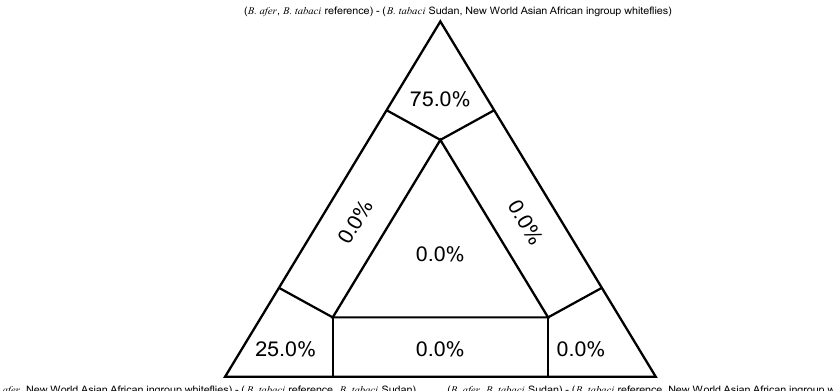
Figure 3. Likelihood map produced from IQ-tree showing the distribution of quartets that support a sister relationship between the reference “B” genome and the Sudan sample produced from the analysis of the concatenated alignment. Results show that 75% of quartets sampled support the Sudan sample together with the remaining samples (not including the reference) while 25% support the Sudan sample together with the reference, when all nucleotide sites are analyzed. These quartets are also relatively decisive in that no quartets provide ambiguous information (i.e., no points in the center or edges of the triangle).